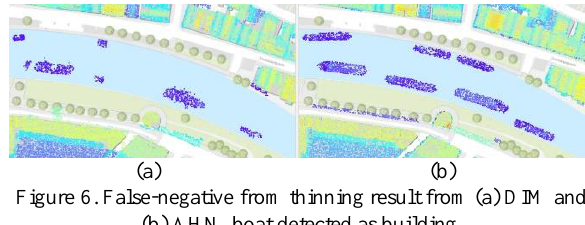
Figure 6. False-negative from thinning result from (a) DIM and (b) AHN, boat detected as building.